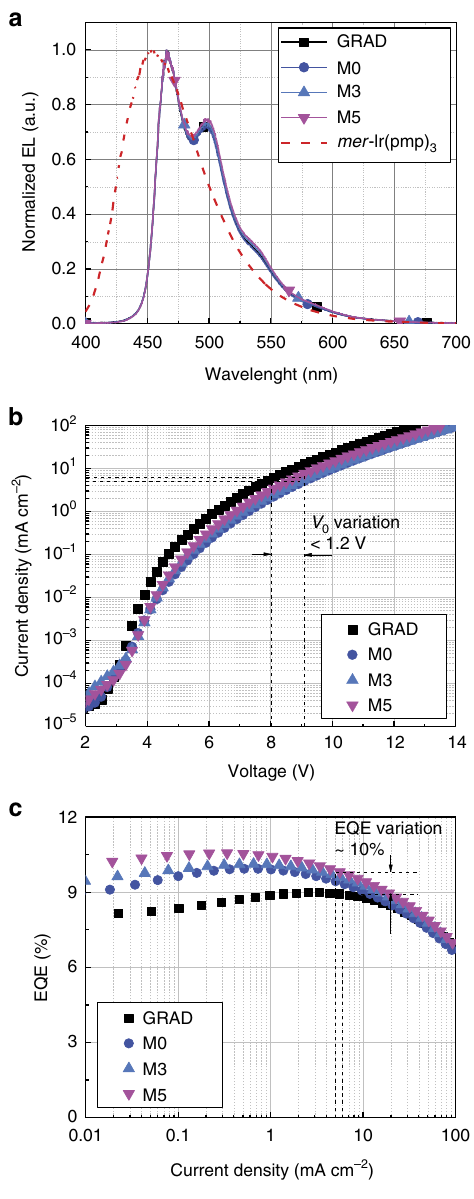
Figure 3 | Performance of the PHOLEDs. ( a ), Normalized electroluminescent (EL) spectra of the GRAD and managed PHOLEDs, M0, M3 and M5, measured at a current density of J 0 ¼ 5mAcm (cid:2) 2 . For comparison, the PL spectrum of the manager [ mer -Ir(pmp) 3 ] is also shown. ( b ) Current density–voltage. ( c ) External quantum efficiency (EQE)–current density characteristics of GRAD and selected managed PHOLEDs. Note that between GRAD and the managed PHOLEDs, the absolute difference of the operating voltages ( V 0 ) and EQE at an initial luminance